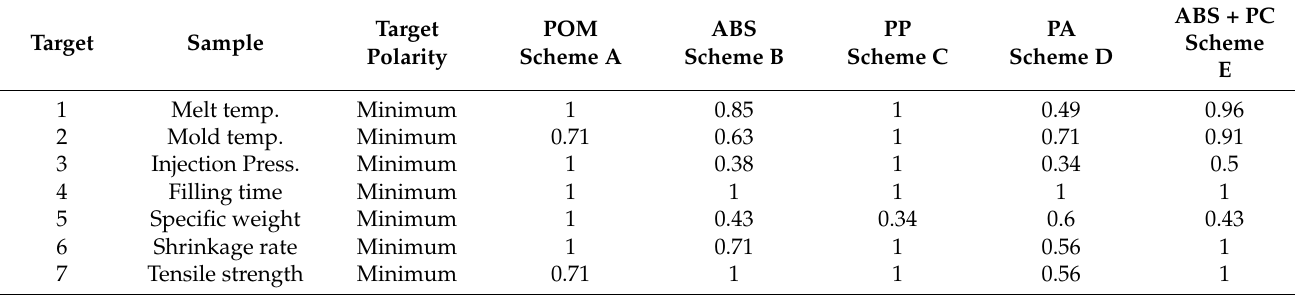
Table 9. Effect measurement processing of effect